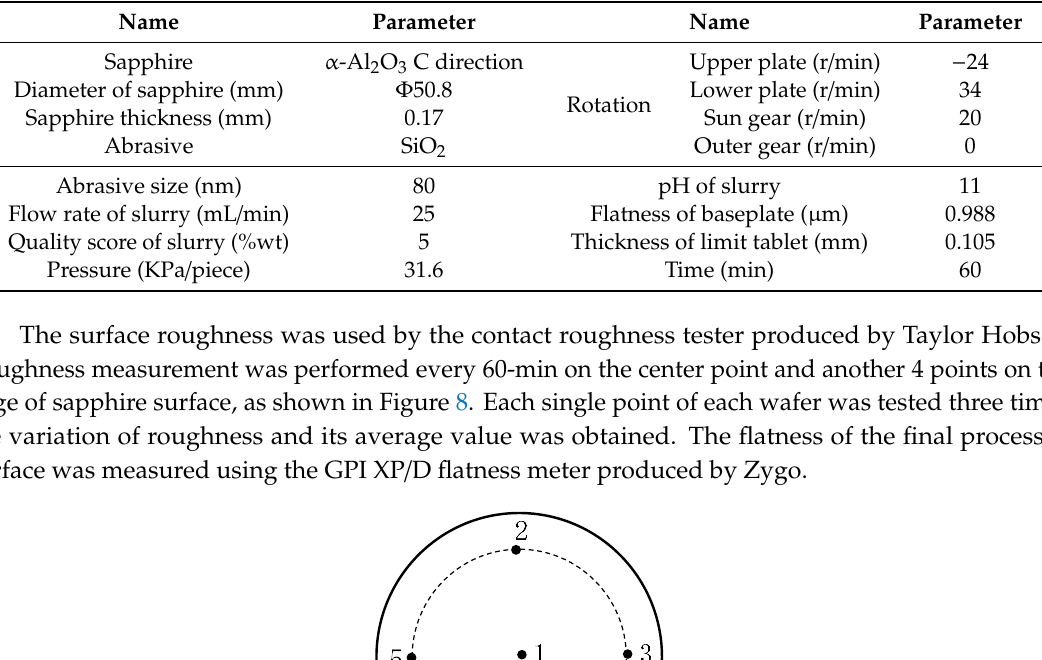
Figure 7. Layer stacked fixture and double-sides polishing equipment: ( a ) double-sides polishing machine; ( b ) layer stacked fixture.